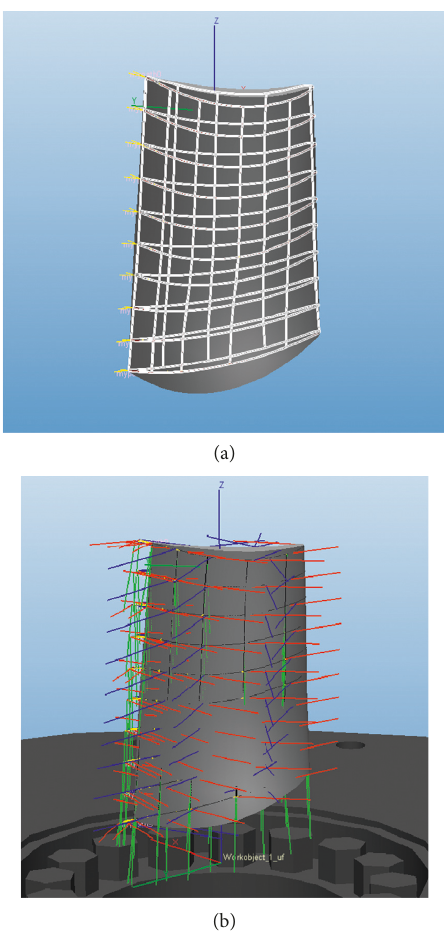
Figure 17: A series of curves (a) and several targets (b) in the robot